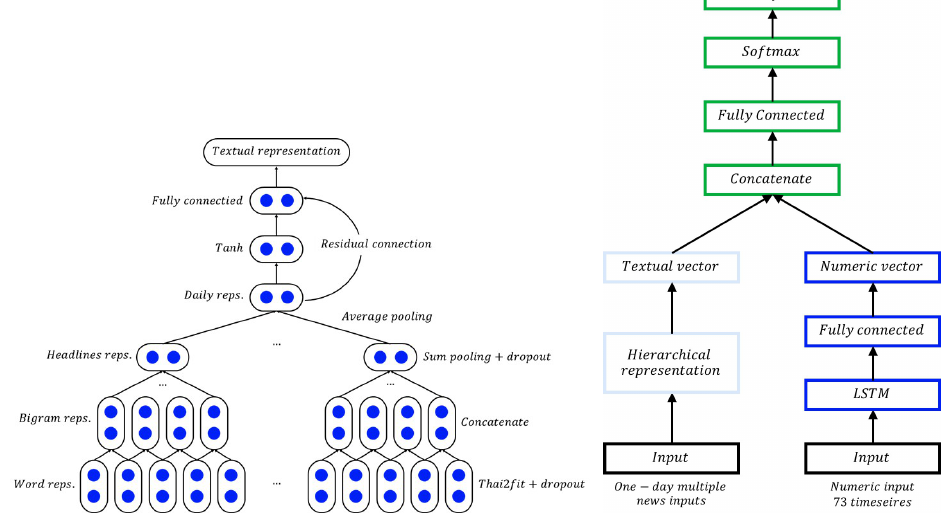
Figure 1. The hierarchical neural network (from Figure 2 in [33]). Detailed structure of a hierarchical representation ( left ). The overview architecture for the whole model ( right